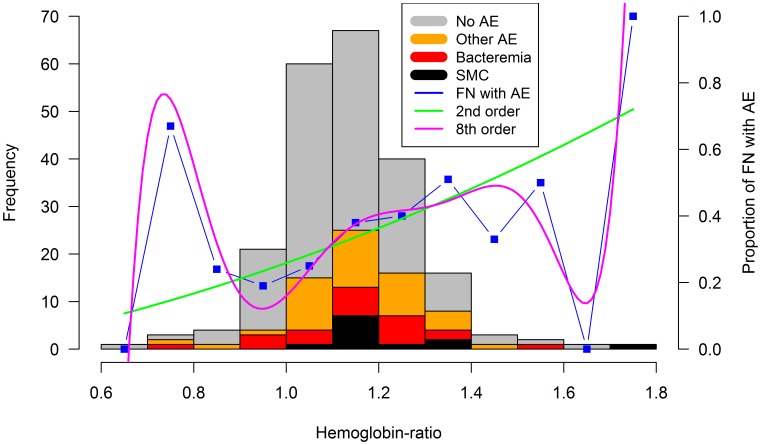
Adverse events versus dehydration, estimated by Hb-ratio.Frequency histogram of FN episodes (left vertical axis). Proportions of FN episodes with any AE measured, and by 2nd and 8th order regression smoothing (right vertical axis).